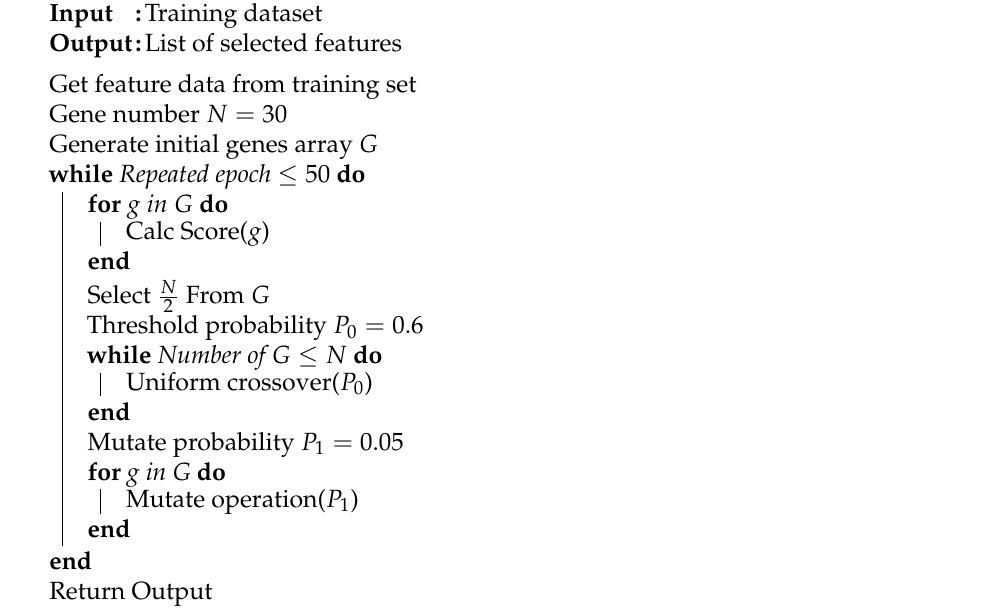
Algorithm 1: Pseudo-code of the genetic algorithm used in the